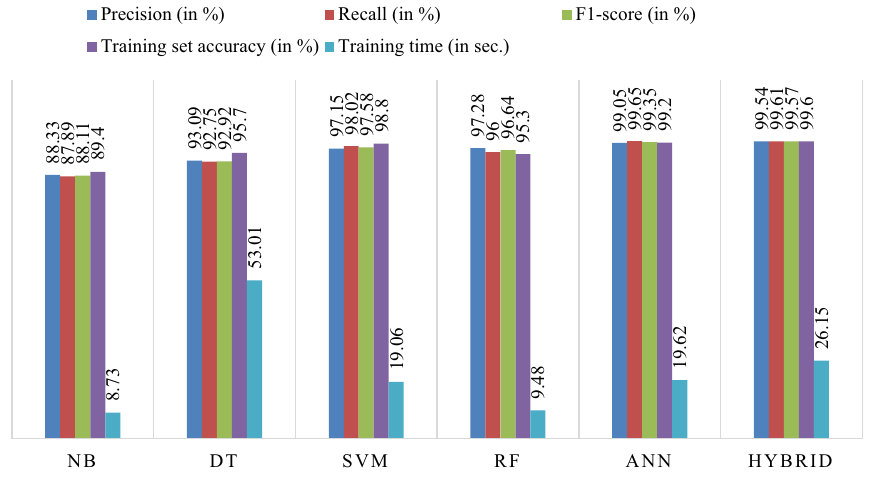
Fig. 4 Performance evaluation for the training